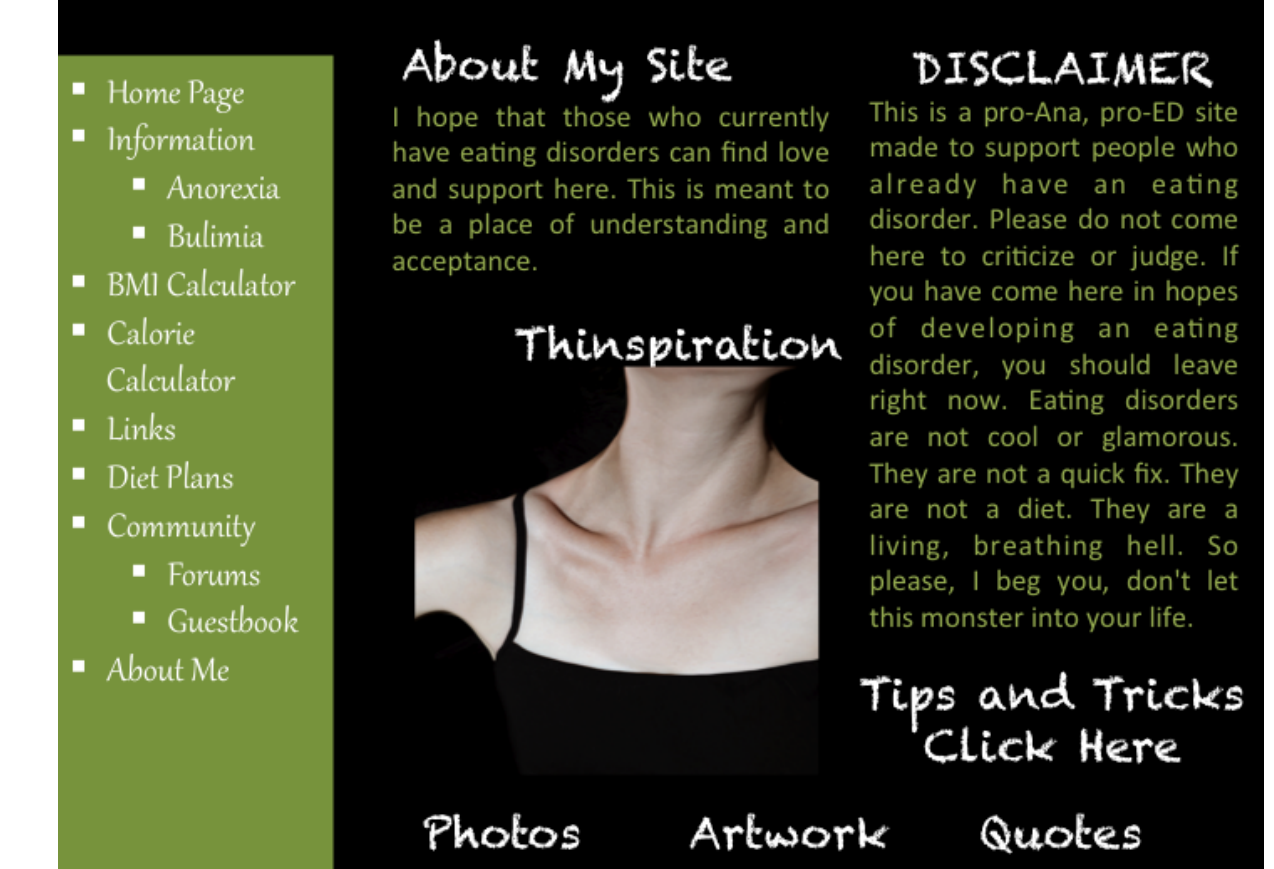
Figure 1. Mock pro-eating disorder website with typical